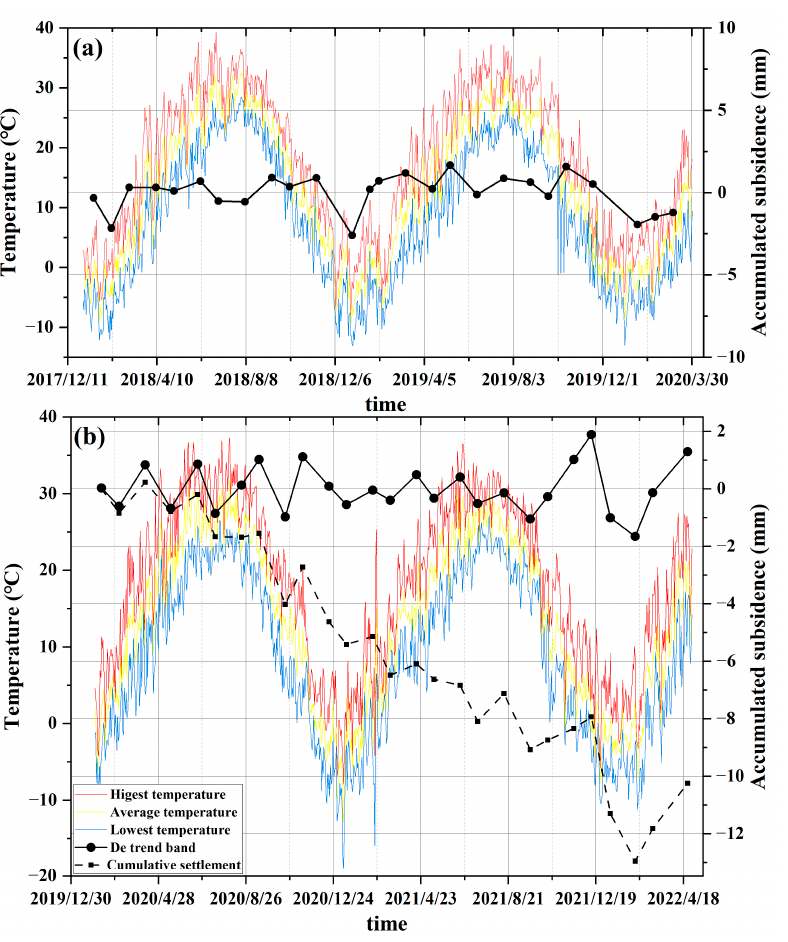
Figure 14. ( a ). Temperature data with surface deposition information from January 2018 to March 2020; the accumulated subsidence is shown in Figure 11a. ( b ). Temperature data with surface deposition information for February 2020 to April 2022.